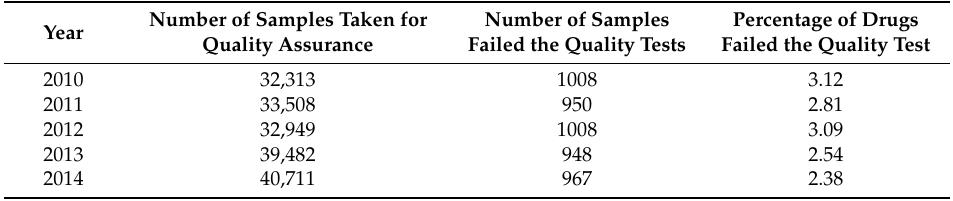
Table 3. Proportion of drugs sample that fail to meet quality standard,